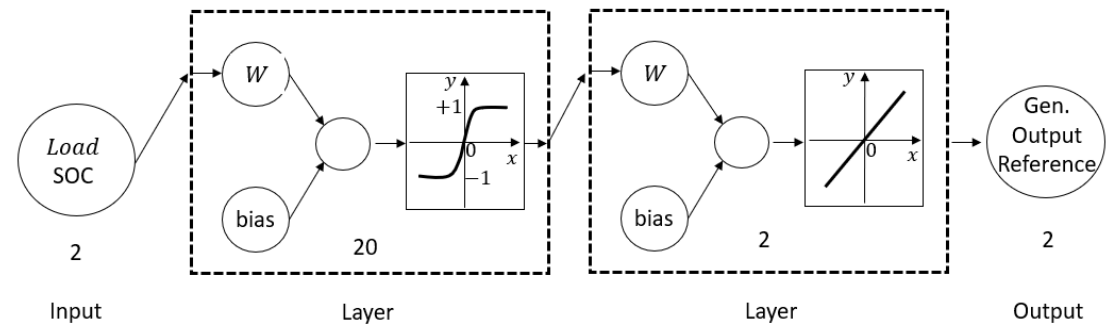
Figure 10. Block diagram of proposed neural network controller.